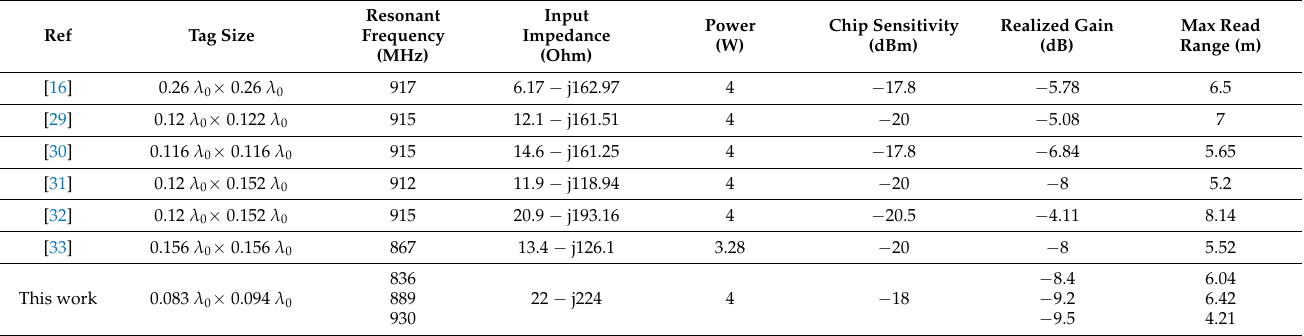
Table 4. Comparison of different metal mountable Tag